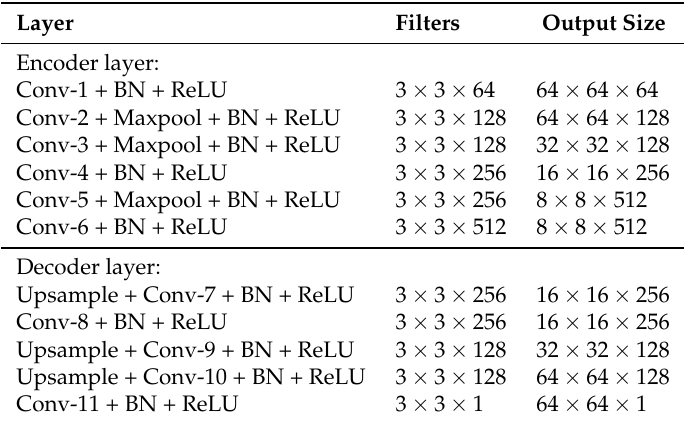
Table 2. Architecture of CAE for a single